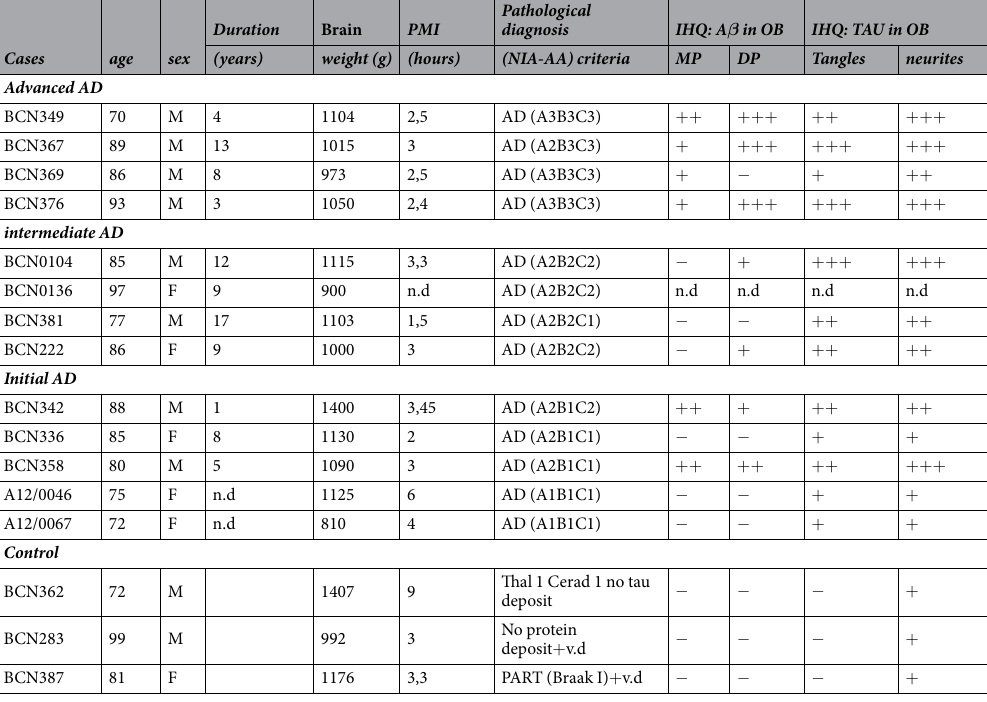
Table 1. Subjects included in the proteomic study. The neuropathological assessment was performed according to Thal phases, CERAD score, NIA-AA guidelines and PART criteria. A β immunopositivity was scored on